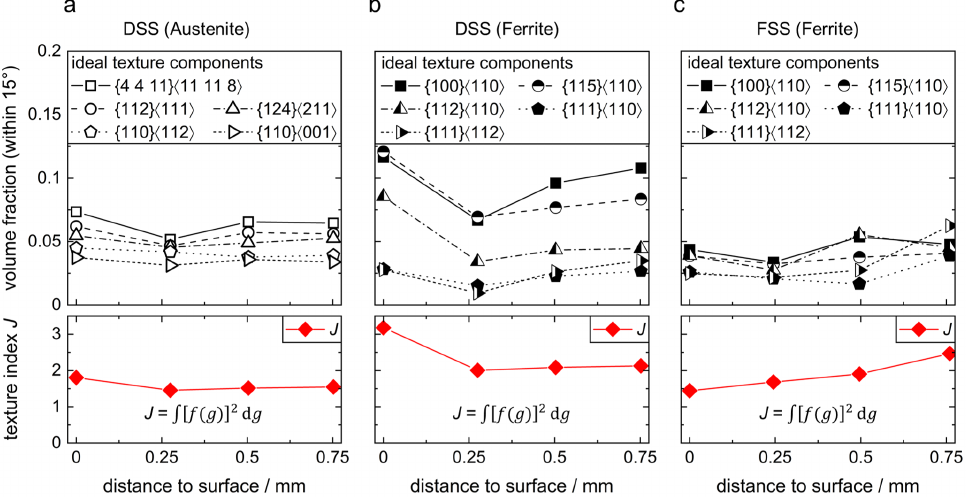
Figure 3. Depth gradients of crystallographic texture from sheet surface to centre of the austenitic phase ( a ) and ferritic phase ( b ) of the DSS and the FSS ( c ), depicted by volume fractions of the main texture components (top row) and the texture index J (bottom